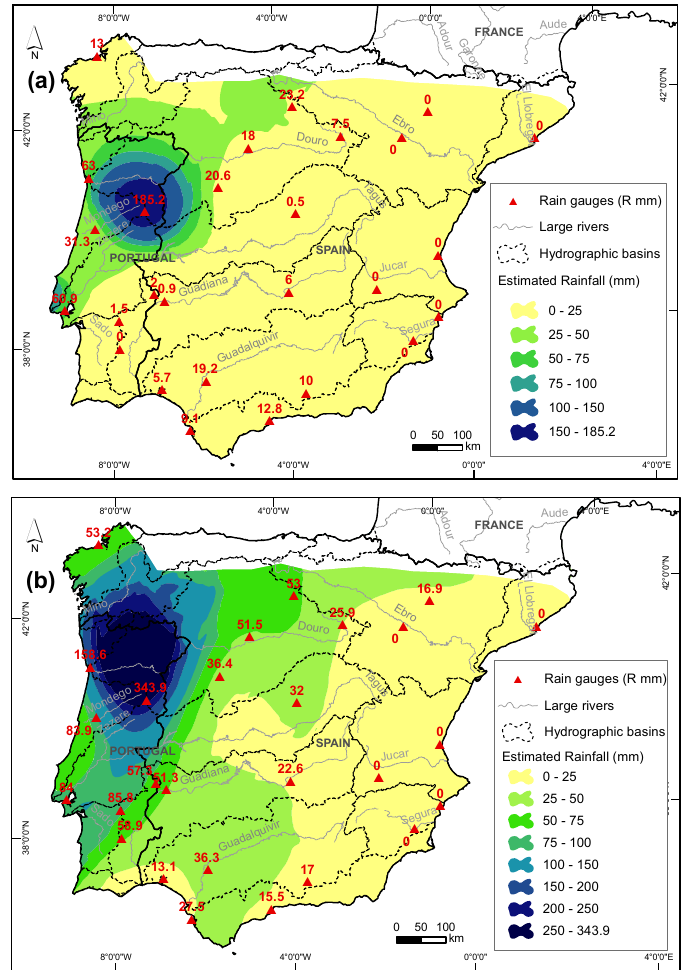
Figure 11. Co-kriging interpolation of total precipitation of 22 December (a) and event cumulated precipitation in 20–28 December 1909 (b) in Iberia.